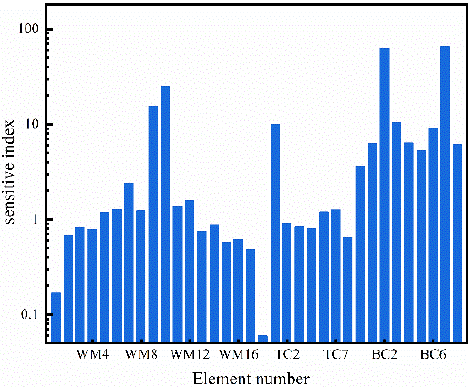
Figure 20. Sensitive indices after TC4 failure.